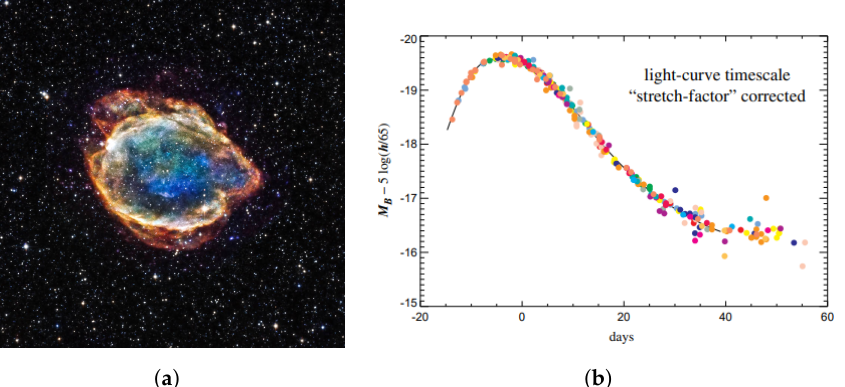
Figure 2. ( a ) Remnants of G299 Type Ia supernova. Adapted from: [13] ( b ) Typical lightcurve of a Type Ia supernova. Adapted from: